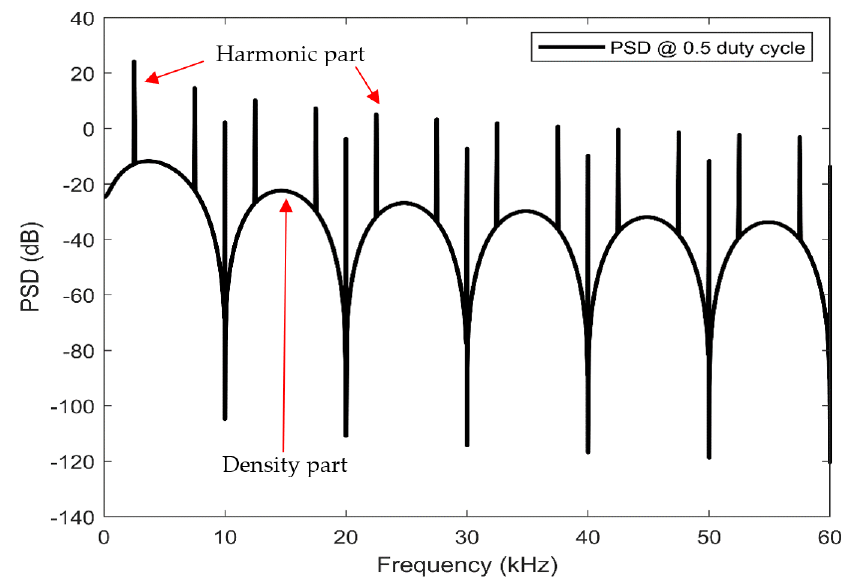
Figure 2. PSD of the switching signal with uniformly distributed random pulse position.